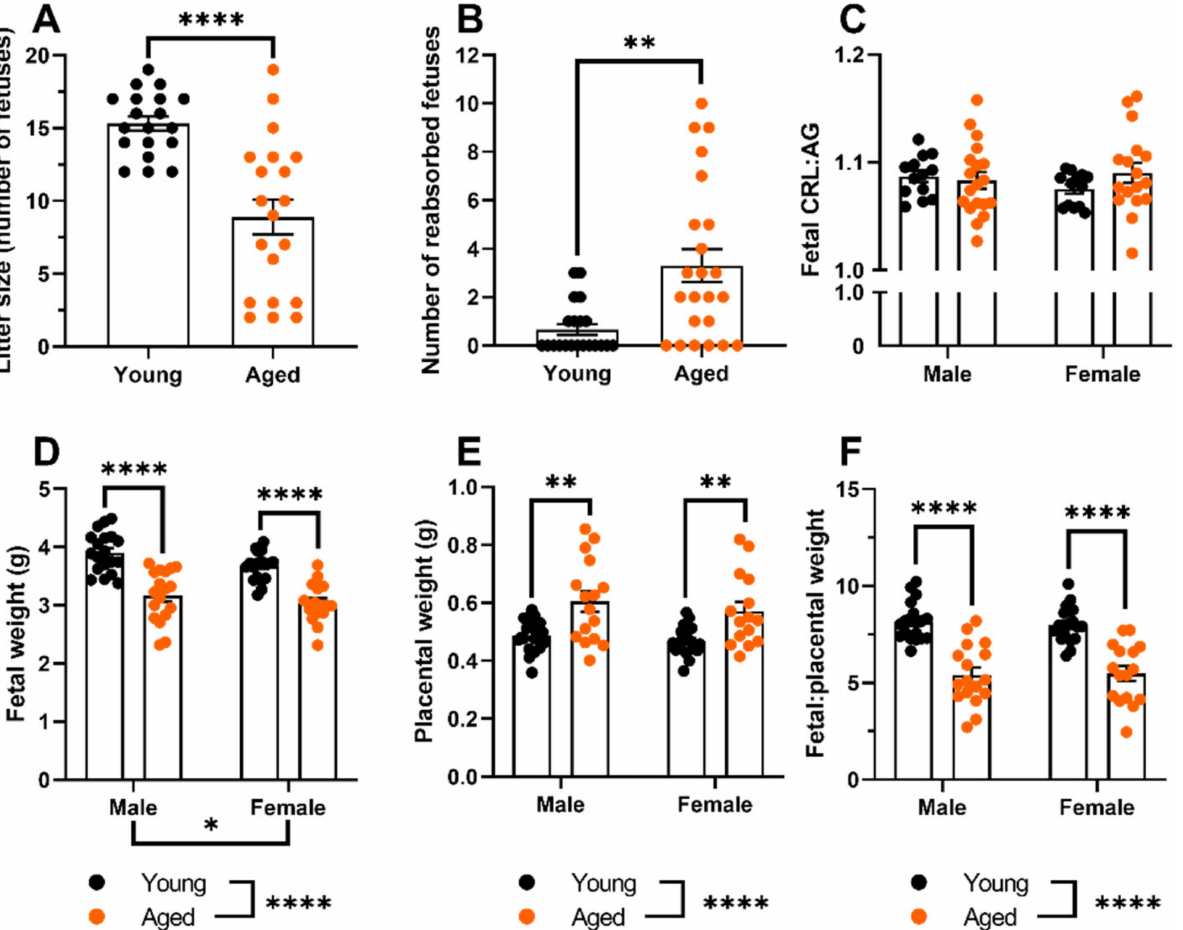
Figure 1. Pregnancy outcomes from young and aged dams at GD 20. ( A ) Litter size; ( B ) Reabsorptions; ( C ) Fetal crown-rump length (CRL):abdominal girth (AG) ratio; ( D ) Fetal weight; ( E ) Placental weight; ( F ) Fetal:placental weight ratio. Data presented as mean ± SEM; n represents litter average; n = 13–19 dams/group. Data are sex-specific means of litter outcomes, where applicable. Pregnancy outcomes were compared using a t -test (litter size), Mann Whitney U-test (reabsorptions), or a two-way ANOVA (dam age vs. fetal sex) followed by Sidak’s post hoc test. * p < 0.05; ** p < 0.01; **** p <